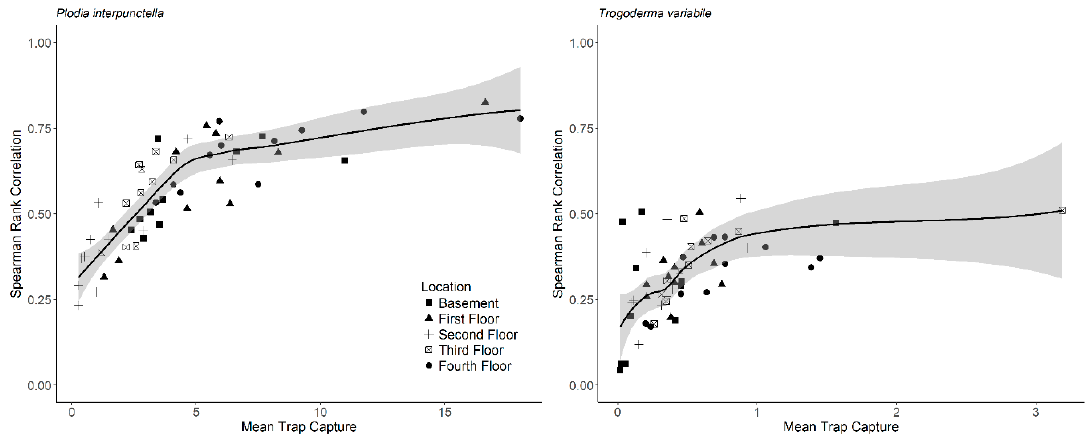
Figure 4. Loess line fit for mean insect capture and Spearman rank correlation for each trap and location. Spearman rank correlation is on the y-axis and represents the average correlation for each trap on a given floor from one year to the next. Mean insect capture is on the x-axis and represents the mean insect captures for each year. The line and range in gray indicate the loess line fit.